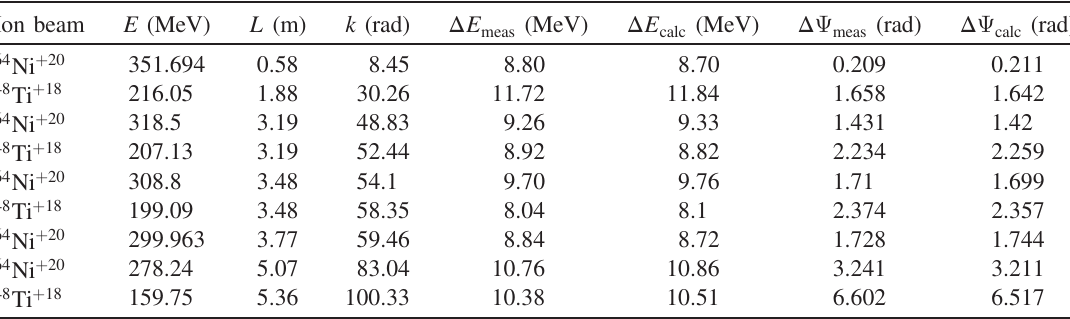
TABLE II. Comparison of analytical and experimental determination of energy gain and phase shift acquired by using superconducting phase